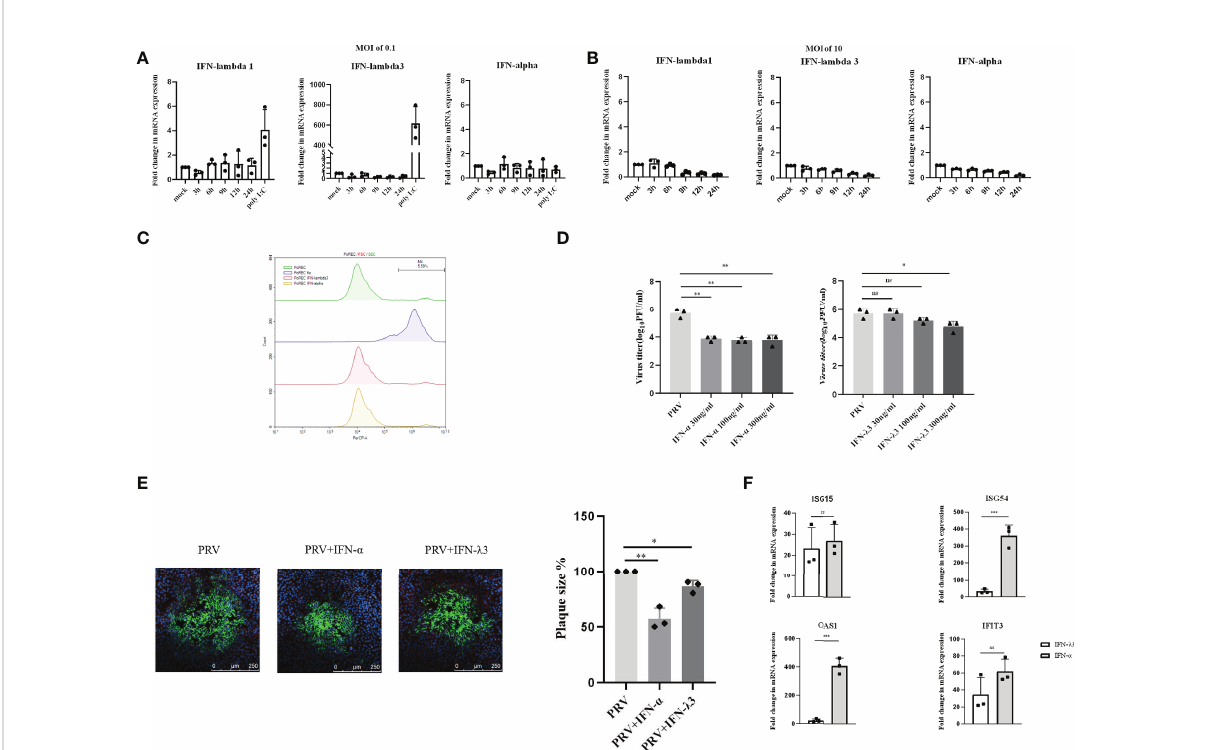
FIGURE 2 Expression and antiviral effect of type I and type III IFNs in response to PRV infection in porcine primary respiratory epithelial cells (PoREC). PoREC were inoculated with (A) low dose PRV (MOI of 0.1PFU/cell) or (B) high dose PRV (MOI of 10PFU/cell) on the apical side. At different time points post inoculation, cell lysates were prepared for RT-qPCR analysis of expression of porcine IFN- a , IFN- l 1 and IFN- l 3. (C) PoREC were treated with IFN- a or IFN- l 3 (300ng/ml) for 24 h, followed by PI staining and fl ow cytometric analysis to assess cell viability. (D) PoREC were pretreated with recombinant porcine IFN- l 3 or IFN- a (30, 100, 300ng/ml) for 24h on the basolateral side, followed by PRV inoculation on the apical side (MOI of 0.1PFU/cell). At 24hpi, cell culture supernatants were collected and viral titers were determined. (E) PoREC were pretreated with recombinant porcine IFN- a or IFN- l 3 (300ng/ml) for 24 h, followed by PRV inoculation. At 2hpi, medium was replaced with a semisolid medium to prevent cell-free spread of PRV particles. Plaque sizes were determined by immuno fl uorescence at 24hpi. (F) PoREC were treated with recombinant porcine IFN- a (grey bars) or IFN- l 3 (black bars)(each at 300ng/ml) for 24 h followed by RT-qPCR analysis of the expression of different ISGs (ISG15, ISG54, OAS, IFIT3). Asterisks indicate statistically signi fi cant differences (ns: non-signi fi cant, *p < 0.05, **p < 0.01, ***p <